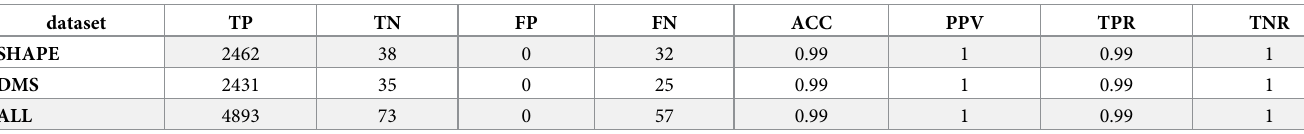
Table 1. The results of validation of RNAthor algorithm for unreliable data identification.